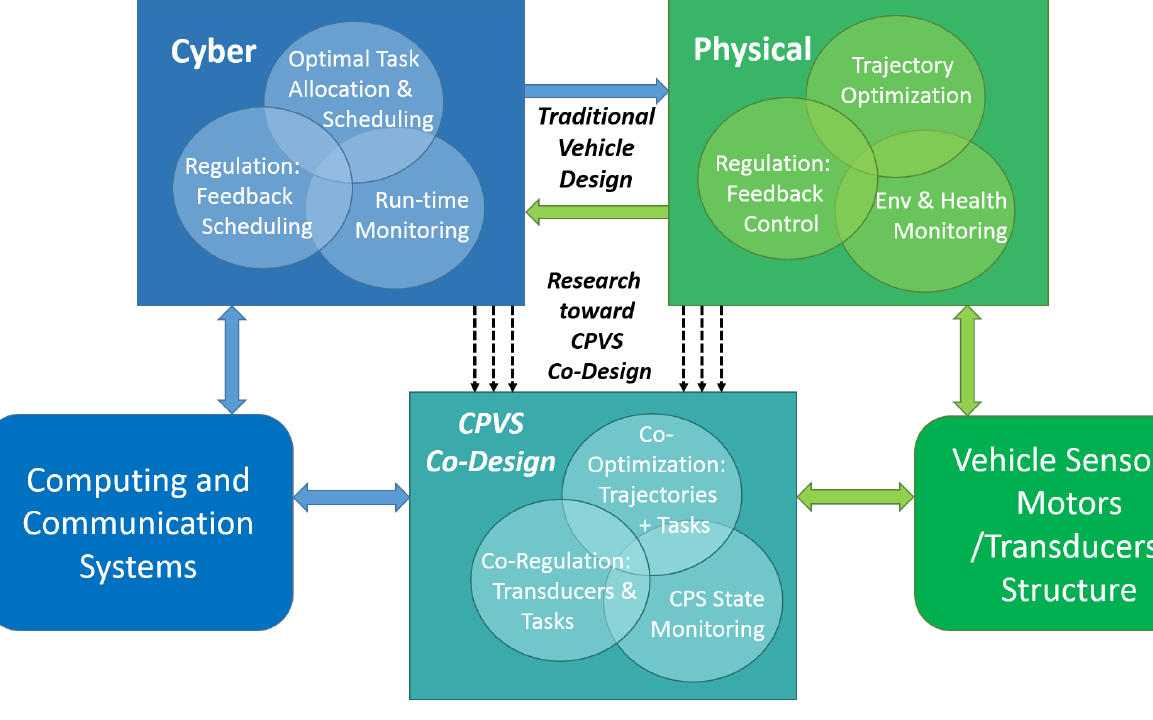
Figure 1. An evolution toward integrated cyber-physical vehicle system (CPVS) run-time